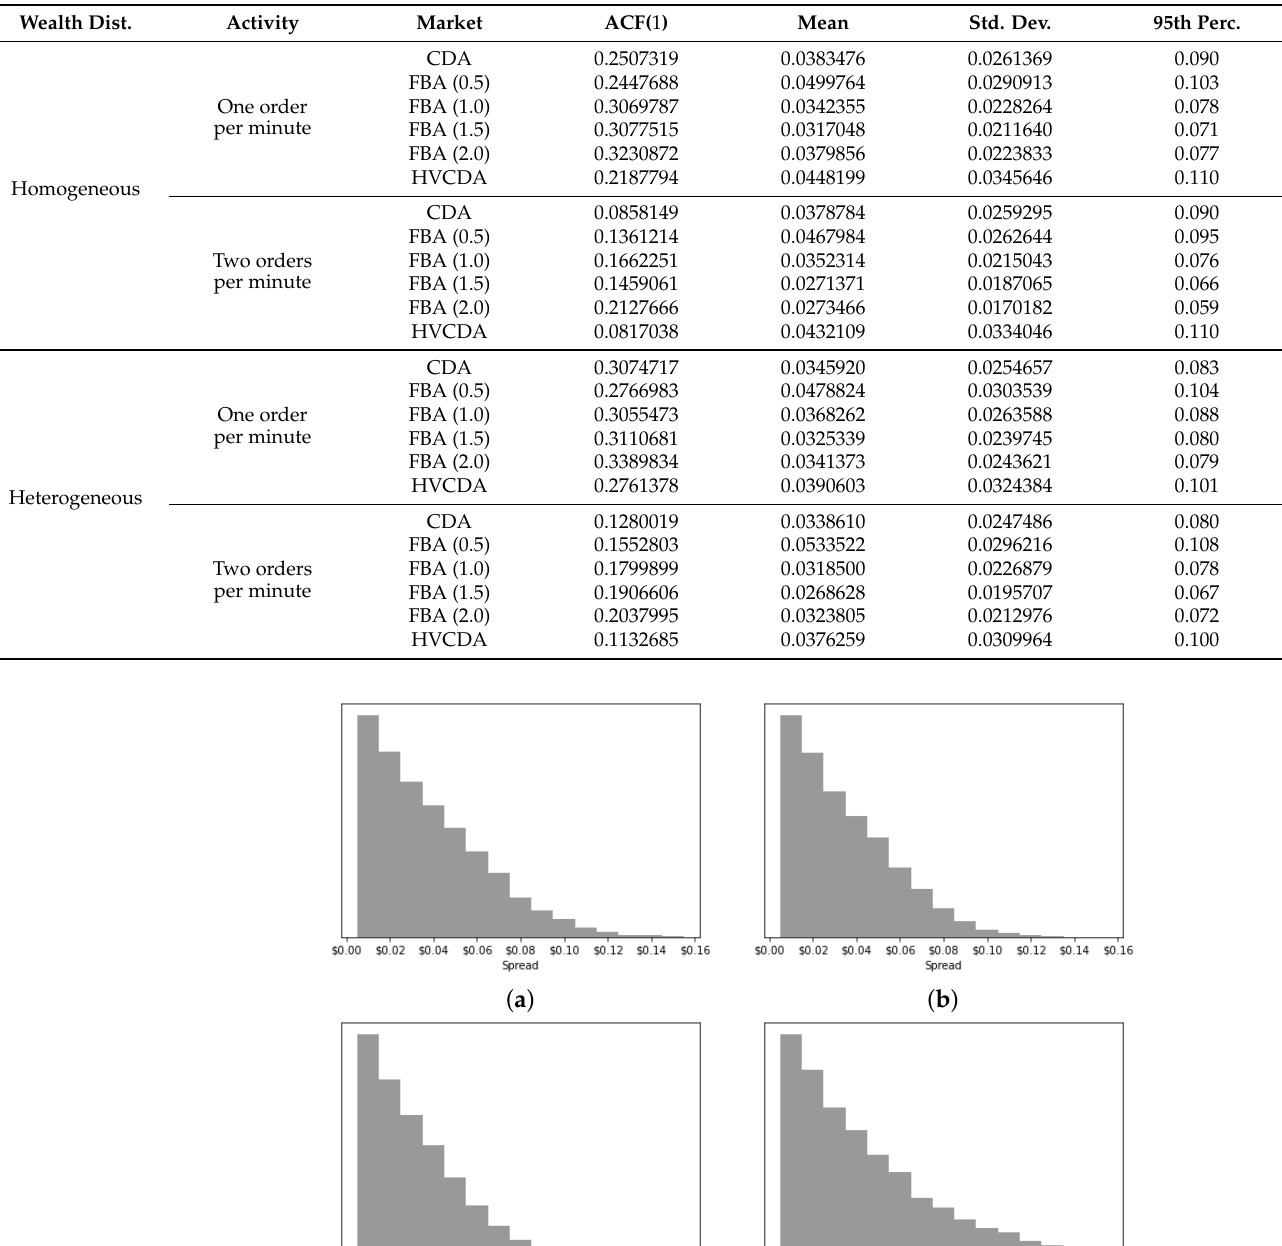
Table 5. Summarized spread statistics. All amounts except ACF(1) are in USD.